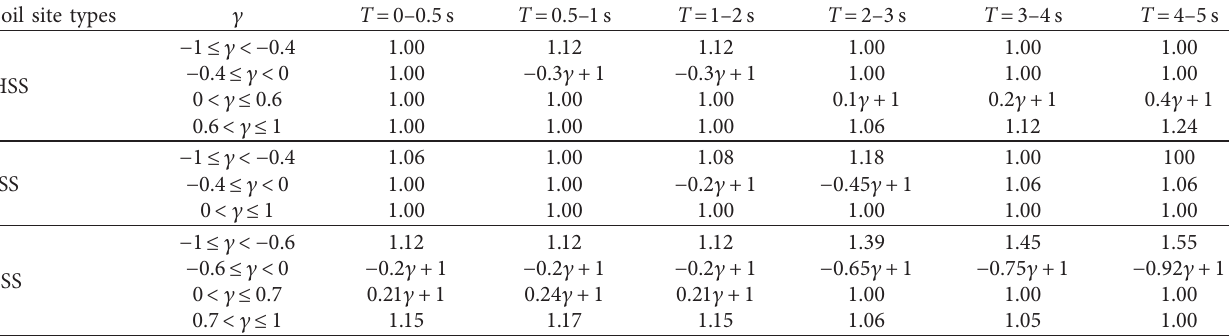
Table 4: Correction coefficient α